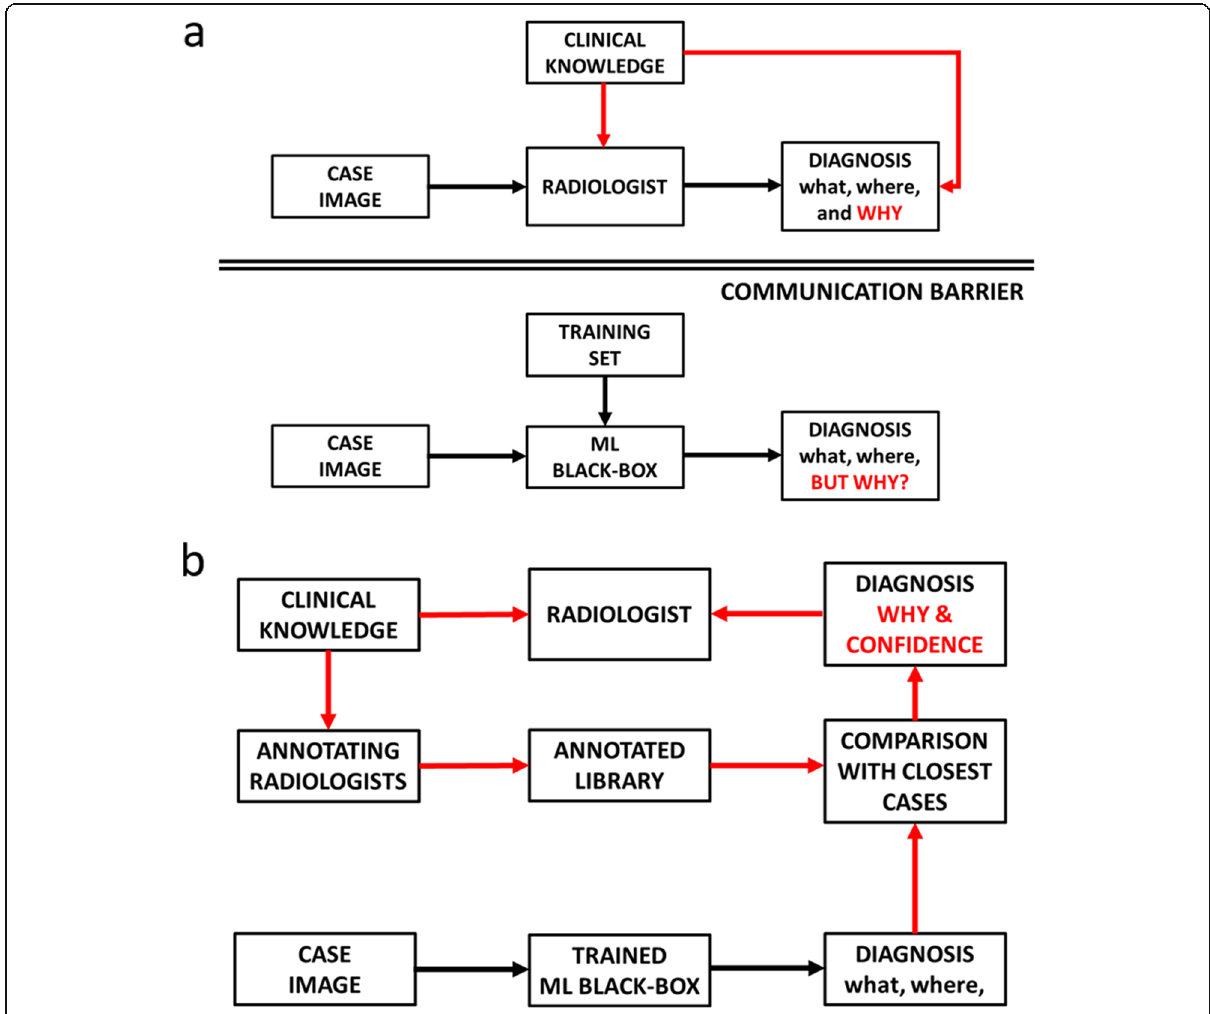
Fig. 5 Schemes of the diagnostic process aided by machine learning tools to show process differences with ( a ) and without ( b ) communication barriers. The second option allows the clinician to retrieve information about classification results ( what ), object localisation ( where ), and added information on the decision-making process ( why ) derived from the annotated